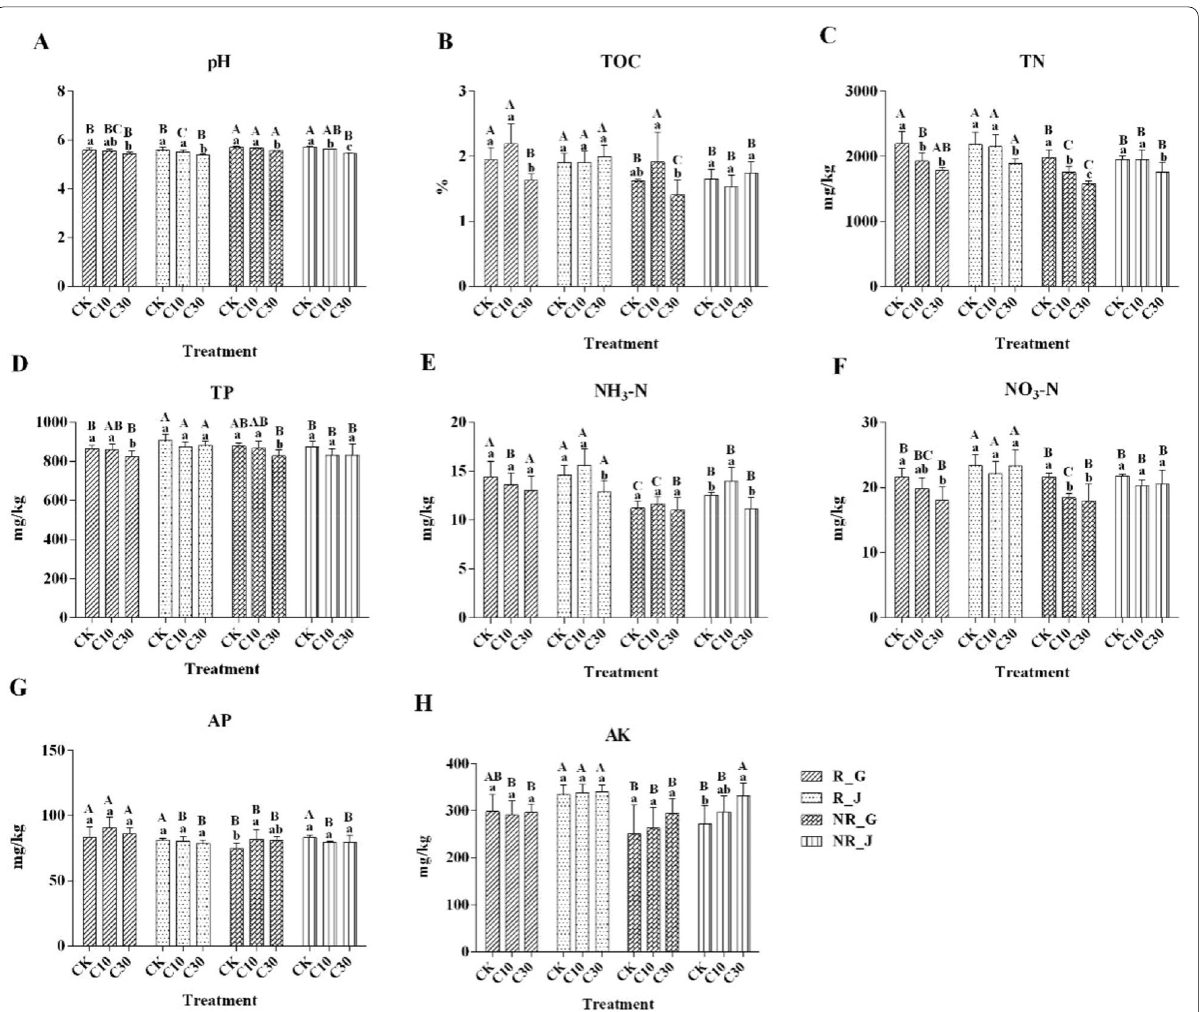
Fig. 2 Effect of Cd on physicochemical properties of soils. Error bars show standard deviation (n significantly different at P < 0.05 based on one-way ANOVA. R rhizosphere soil samples, NR bulk soil samples, G B. napus , J B. juncea , CK treatment with 0 mg/kg Cd, C10 treatment with 10 mg/kg Cd, C30 treatment with 30 mg/kg